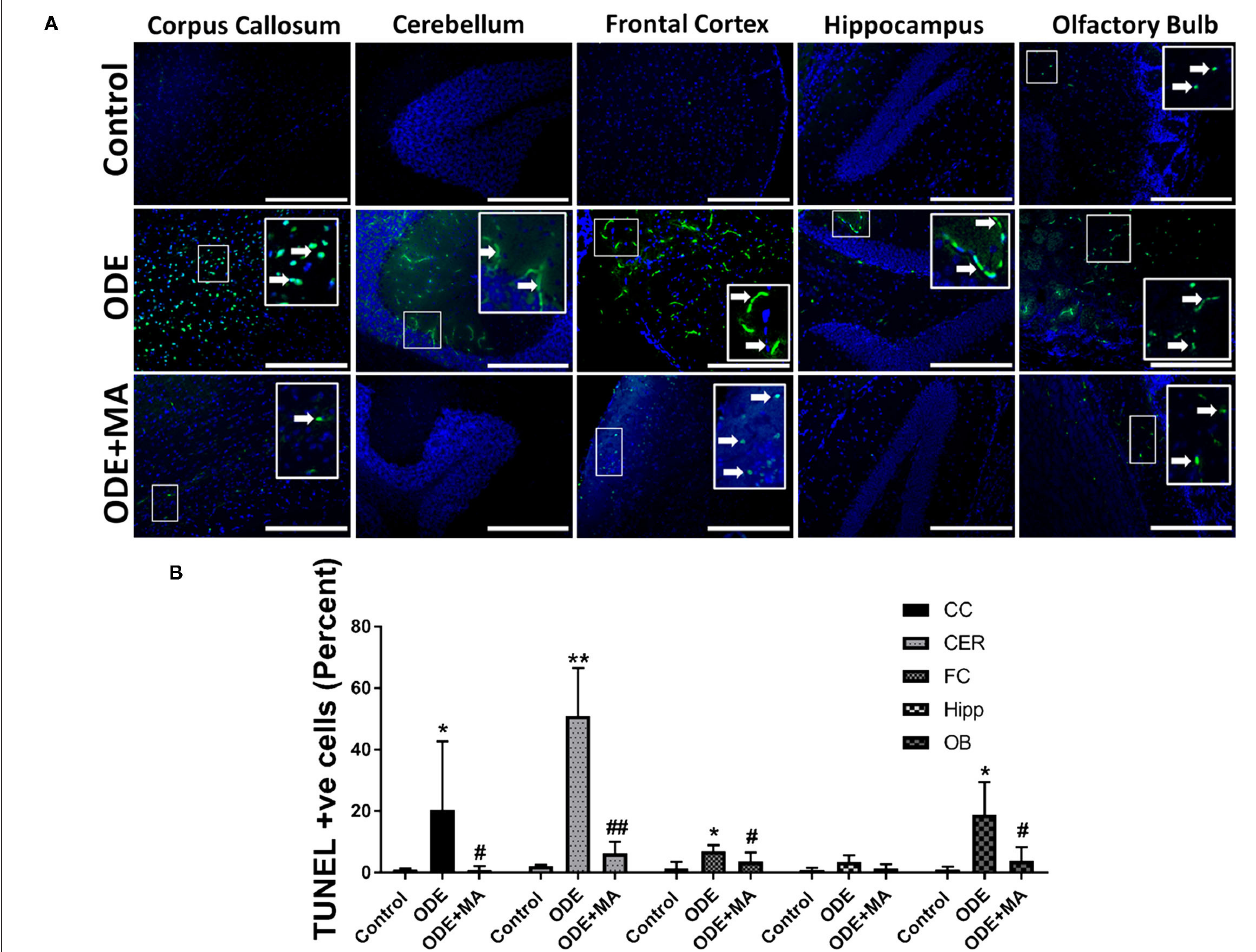
FIGURE 7 | ODE exposure induces neurodegenerative changes in various regions of mice brain. Paraffin-embedded sections from perfused mice brain were labeled with deoxyuridine triphosphate (dUTP)-FITC (white arrow; apoptosis marker, FITC, green), and nucleus was stained with DAPI (blue) (A) . The total number of cells (DAPI, blue) and terminal deoxynucleotidyl transferase dUTP nick end labeling (TUNEL) positive cells (FITC, green) per field (20X) were counted in a total of five random fields by a blinded investigator. Compared to control, ODE-exposed mice showed a higher number of TUNEL positive cells in the corpus callosum, cerebellum, frontal cortex, and olfactory bulb of the brain. MA (C11) significantly reduced the number of TUNEL positive cells in the corpus callosum, cerebellum, frontal cortex, and olfactory bulb regions of the mice brain (B) [ n = 5, *exposure effect, # MA (C11) treatment effect, p < 0.05, micrometer bar = 50 µ